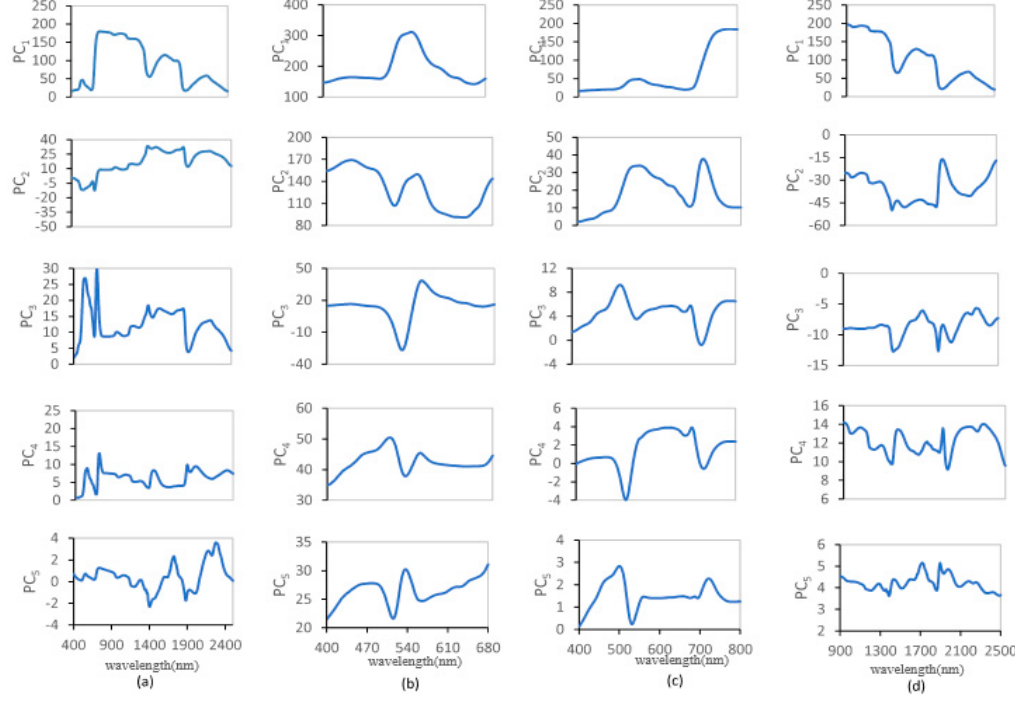
Figure 3. The five leading principal components (PCs) derived from the simulated reflectance data for the ranges 400–2500 nm ( a ), 400–680 nm ( b ), 400–800 nm ( c ) and 900–2500 nm ( d ). PC i means the i